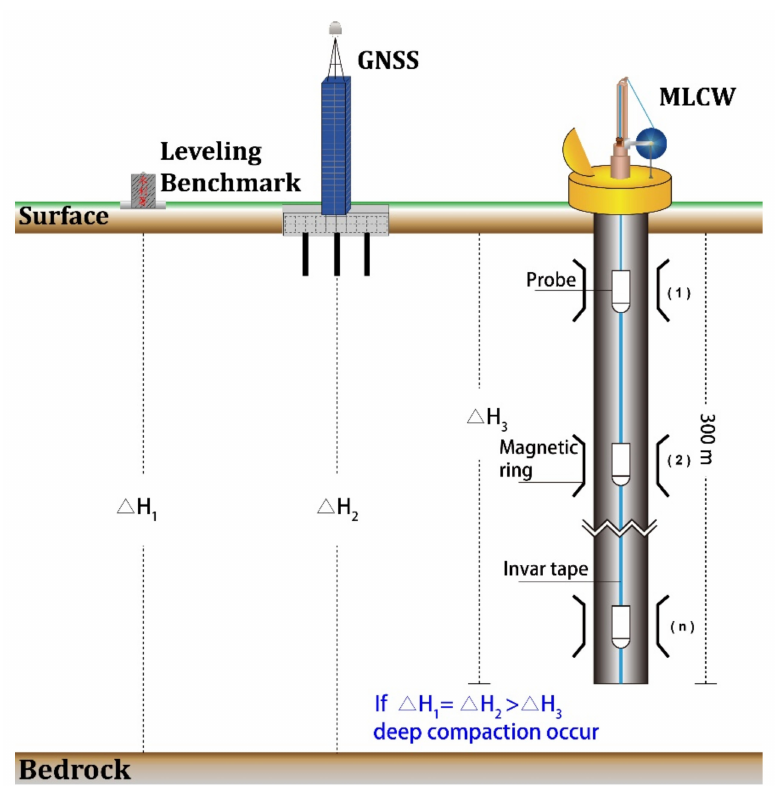
Figure 9. The depths of compaction detected through leveling, GNSS (GPS), and MLCWs ( ∆ H 1 , ∆ H 2 , and ∆ H 3 ). Applying linear regression analysis to obtain the average velocity of leveling ( V l ) and MLCWs ( V m ), the deeper compaction rate ( V d ) is the difference between the velocity of leveling and MLCW ( V d = V l − V m